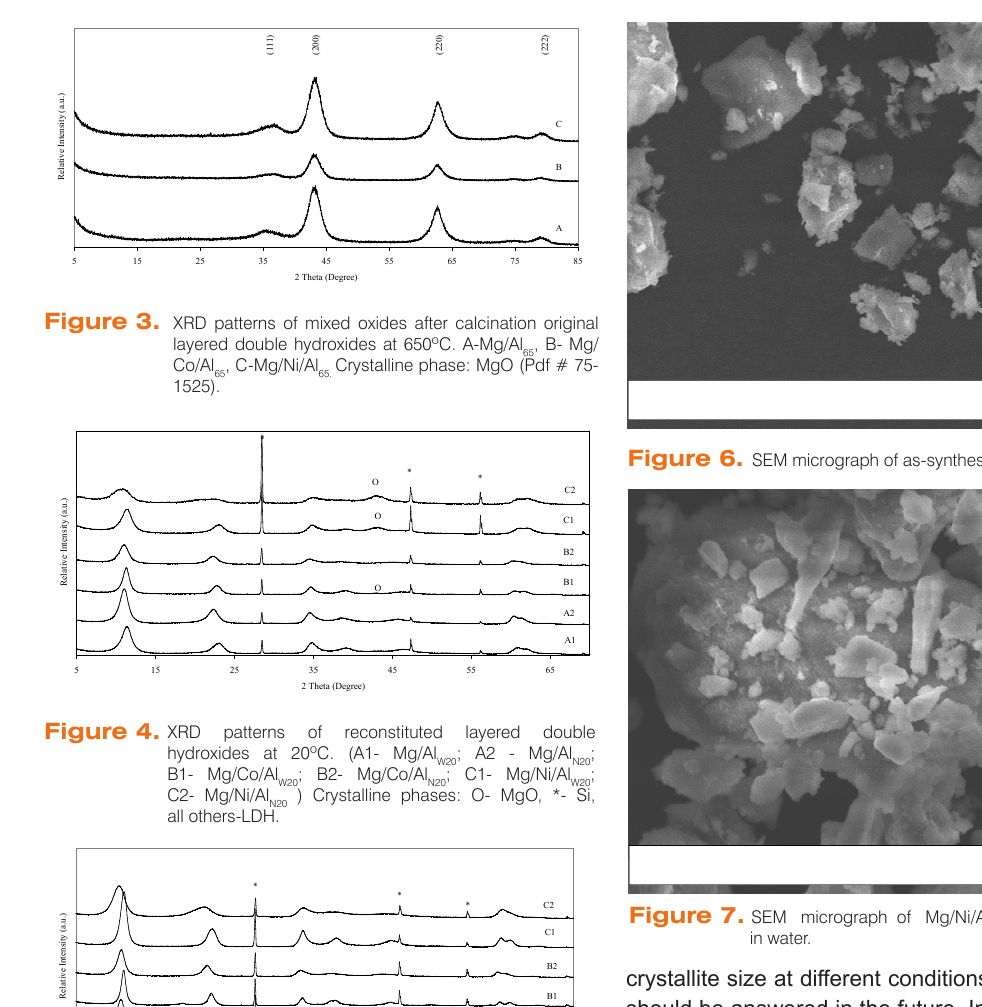
LDH after hydration W20